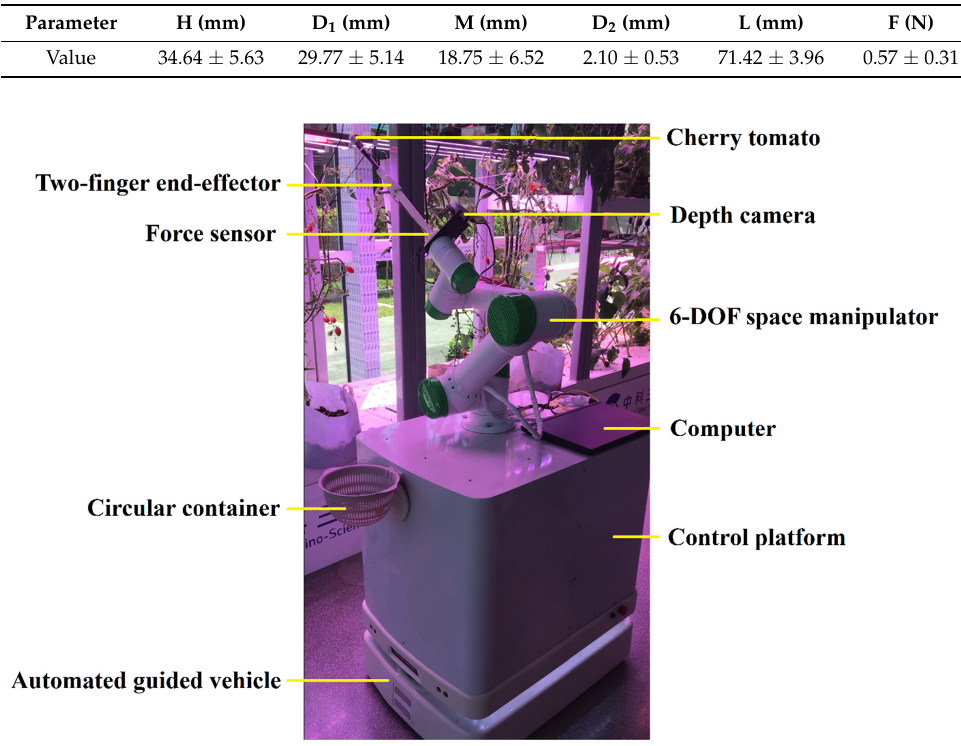
Figure 2. Harvesting robot for cherry tomatoes. Table 1. Results of basic shape parameters of cherry tomato samples (values are means ± standard deviations). Table 2. Factors and levels of the Box–Behnken